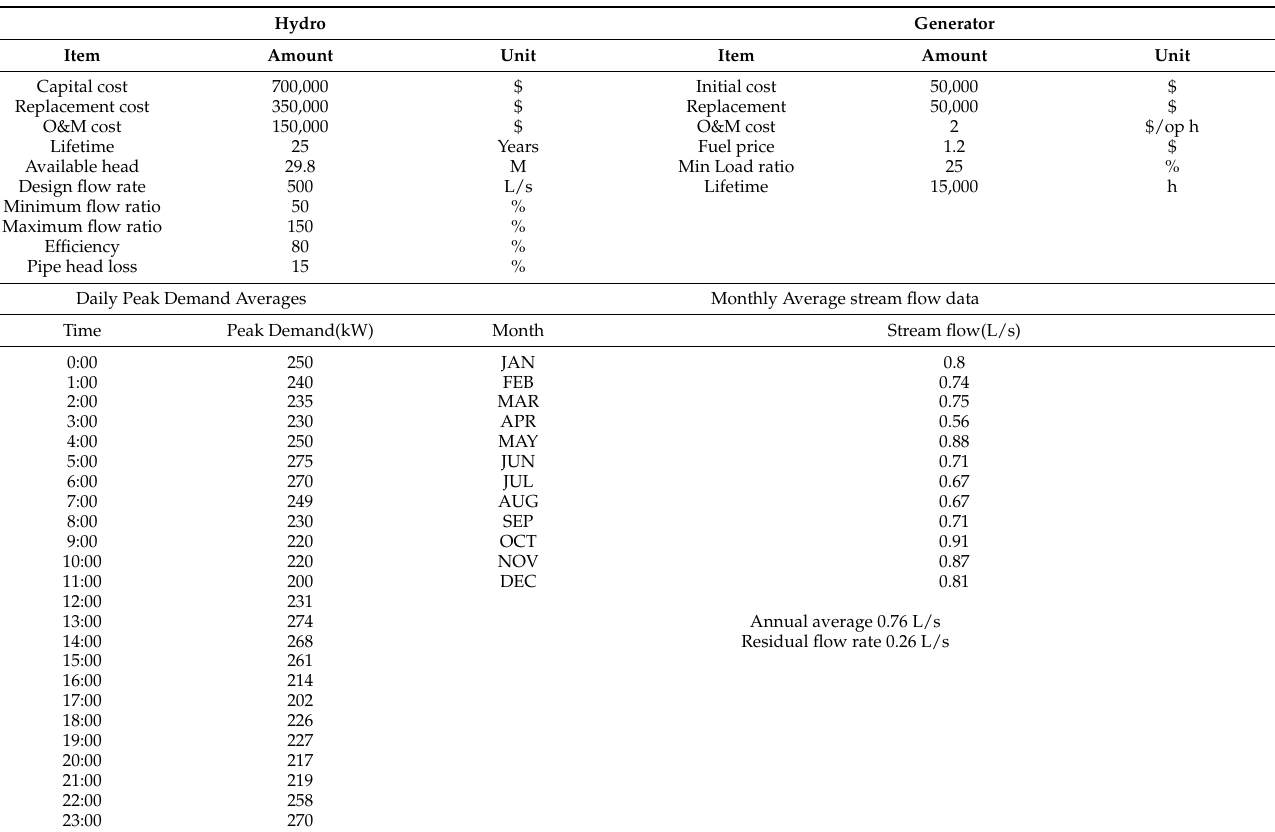
Figure 14. HOMER system architecture showing the interconnections of the loads, components, and resources. Figure 15 shows HOMER result table with base system (BS) and design options 1,2 and 3 indicating technical and economic parameters of the simulated data. Figure 15. The result table showing the architectural design and cost comparison of simulated sys- tem, highlighting the base system (BS) and design options 1, 2, and 3.